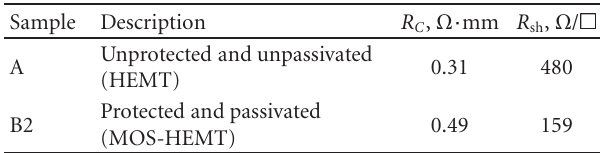
Figure 3: Current-voltage ( I - V ) characteristics on 5 μ m TLM gap spacing of annealed Ohmic contacts under di ff erent Al etch times prior to Ohmic metal deposition. Table 1: Summary of results for the optimised R C and R sh values on HEMT and MOS-HEMT samples in the AlN/GaN material system. Sample